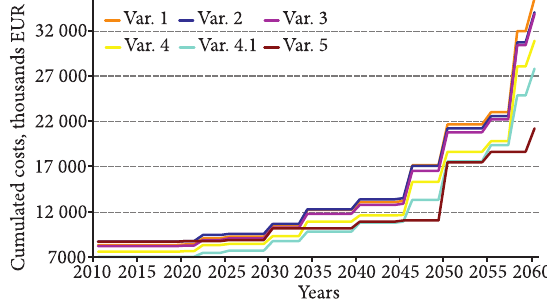
Fig. 13. Graph – the course of cumulated costs (thousands EUR) of all variants for the period of 50 years (the price index of 6%)